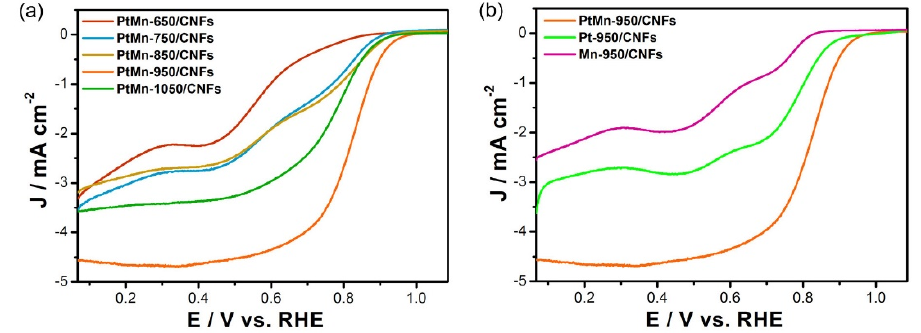
Figure 4. ( a ) Oxygen reduction reaction (ORR) polarization curves of PtMn ‐ X/CNFs (X = 650, 750, 850, 950, and1050)inO 2 -saturated0.10MKOH.( b )ORRpolarizationcurvesofPtMn-950 / CNFs, Pt-950 / CNFs, 950, and 1050) in O 2 ‐ saturated 0.10 M KOH. ( b ) ORR polarization curves of PtMn ‐ 950/CNFs, Pt ‐ and Mn-950 / CNFs in O 2 -saturated 0.10 M KOH (rotation rate: 1600 rpm; sweep rate: 10 mV s − 1 950/CNFs, and Mn ‐ 950/CNFs in O 2 ‐ saturated 0.10 M KOH (rotation rate: 1600 rpm; sweep rate: 10 mV s ‒ 1 ).